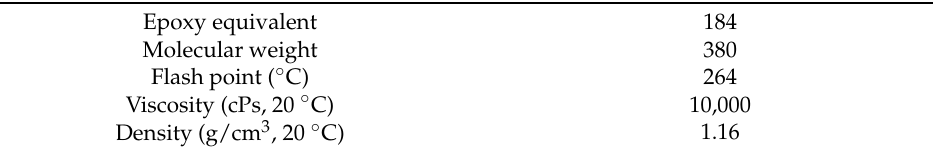
Table 1. Physical properties of epoxy resin.